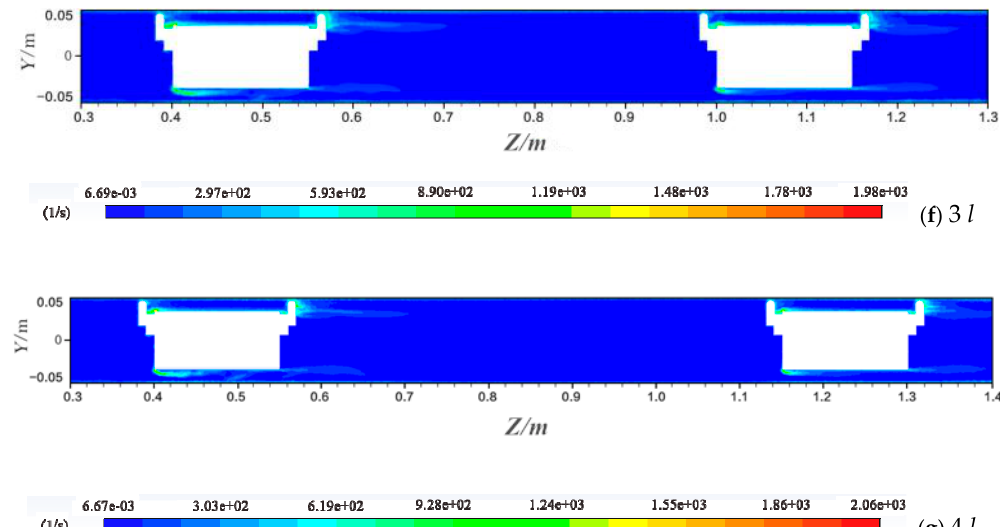
Figure 15. Vortex distribution cloud map of the YZ plane under different vehicle spacings. ( a ) L = 0.5 l . ( b ) L = l . ( c ) L = 1.5 l . ( d ) L = 2 l . ( e ) L = 2.5 l . ( f ) L = 3 l . ( g ) L = 4 l .